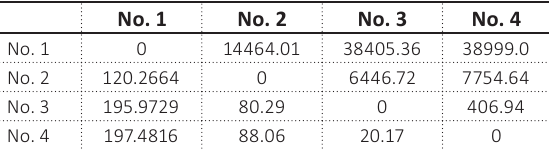
Table 4. Countries and clusters